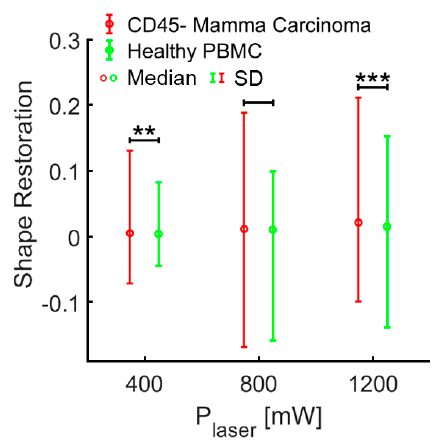
changes are very small.